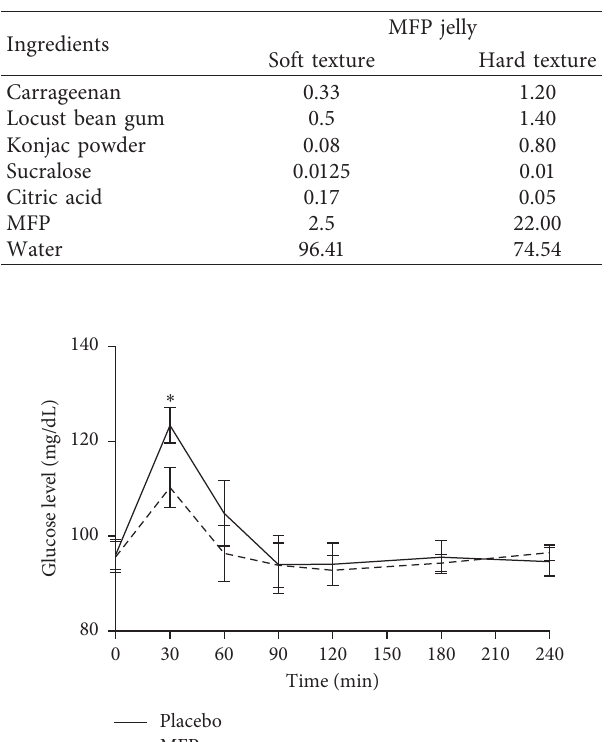
Table 1: Amount of ingredient (%) in the anthocyanin-rich mulberry fruit powder (MFP) jelly.